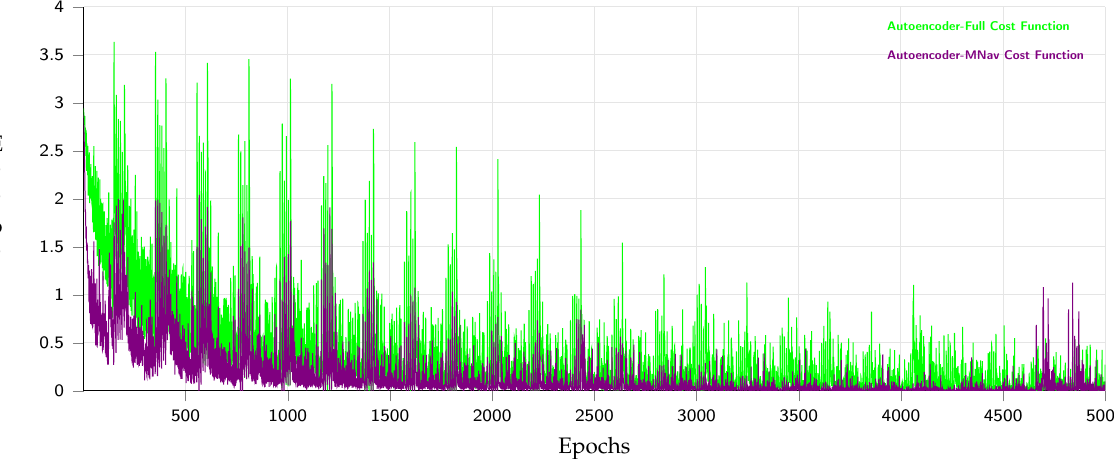
Figure 22. Auto-encoder behavior with navigation meshes and the full